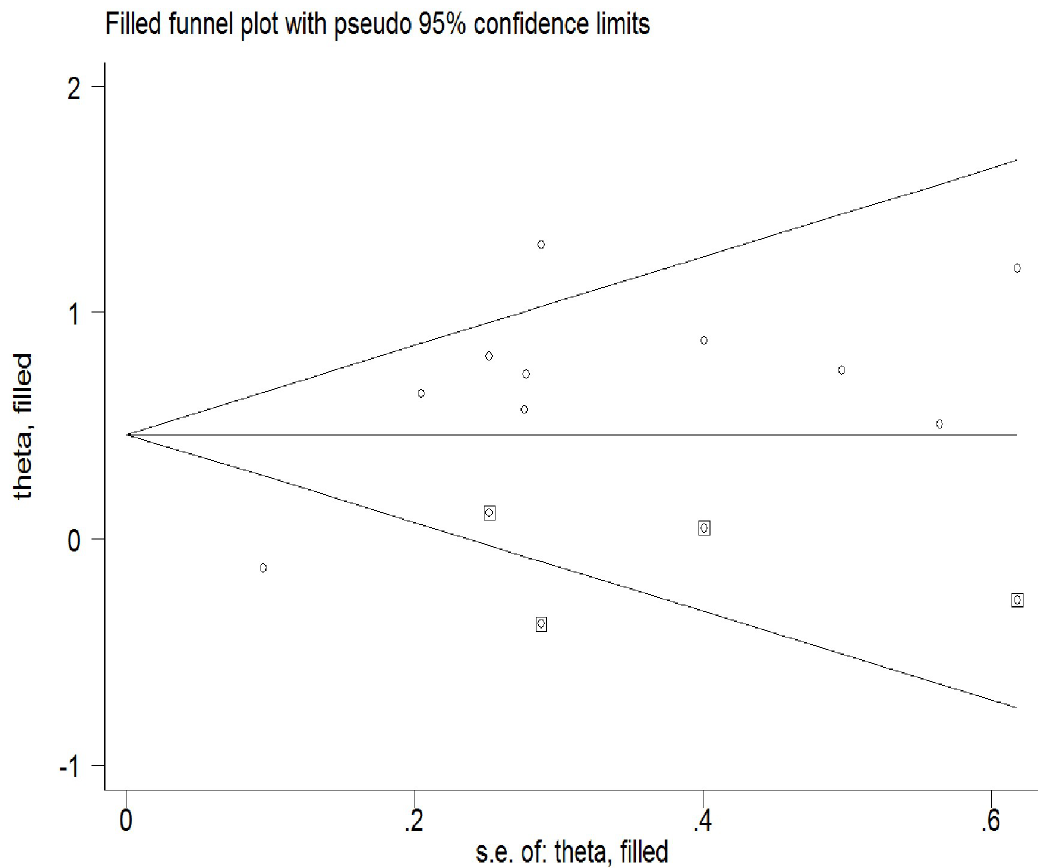
Fig 4. Funnel plot after Tweedie’s and Duval’s trim and fill analysis (Filled by four studies).